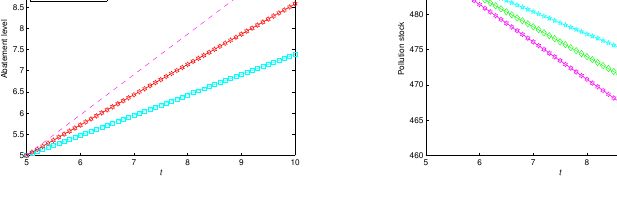
Figure 8. The effects of µ i ( i = 1 , 2) Figure 9. The effects of µ i ( i = 1 , 2) on Yunyang County’s abatement levels of on pollution stock of cooperative cooperative transboundary pollution transboundary pollution problems.